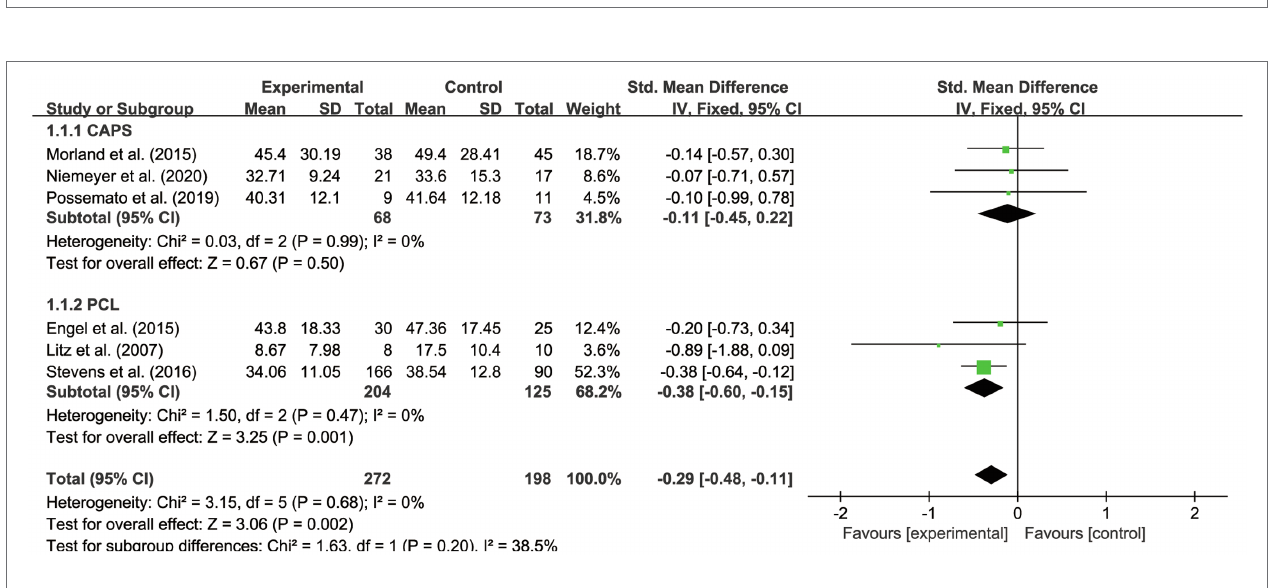
FIGURE 4 | Forest plot of effects of IBI based on various contents.